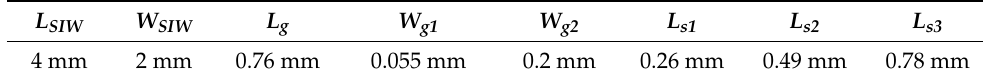
Figure 5. Simulated results of the proposed bandpass filter with different ( a ) SSPPs length 𝐿 𝑆 . ( b ) SIW width 𝑊 𝑆𝐼𝑊 . Table 2. The dimensions of the BPF. Table 2. The dimensions of the BPF.